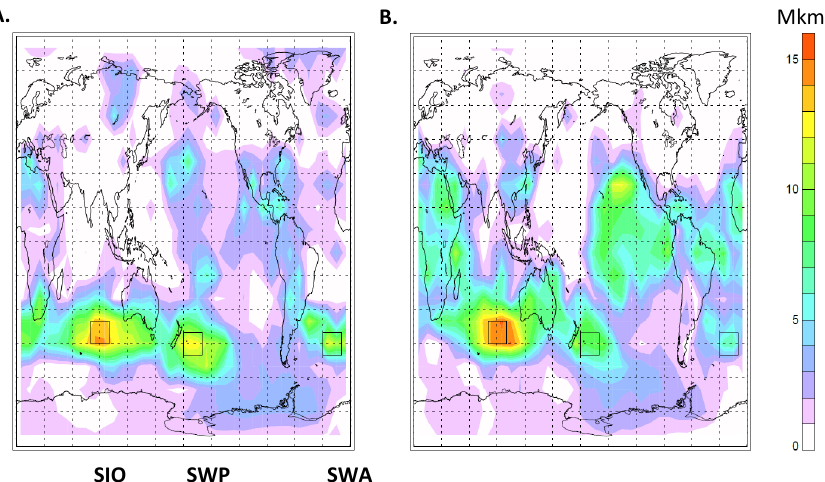
Figure 4. (a) The cumulative area of significant positive surface temperature anomalies poleward of 65 ◦ S (in millionkm 2 ) produced by compositing months having negative surface pressure anomalies (thresholded at the 10th percentile) in each 10 ◦ × 10 ◦ (longitude × latitude) box, obtained from deseasonalised monthly ERA-Interim reanalysis data for 1979–2012 (Dee et al., 2011). The three boxes define the positions referred to in the text as southern Indian Ocean (SIO), southwestern Pacific (SWP) and southwestern Atlantic (SWA). (b) shows the opposite relationship, i.e. the area of negative temperature anomalies produced by compositing months of positive surface pressure anomalies (thresholded at the 90th percentile). The grid spacing is 15 ◦ in longitude and latitude. For reference, the area of the Antarctic continent is 14 millionkm 2 and the area poleward of 65 ◦ S is 25 millionkm 2 .